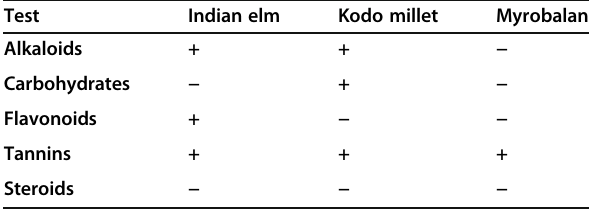
Table 3 Phytochemical investigation